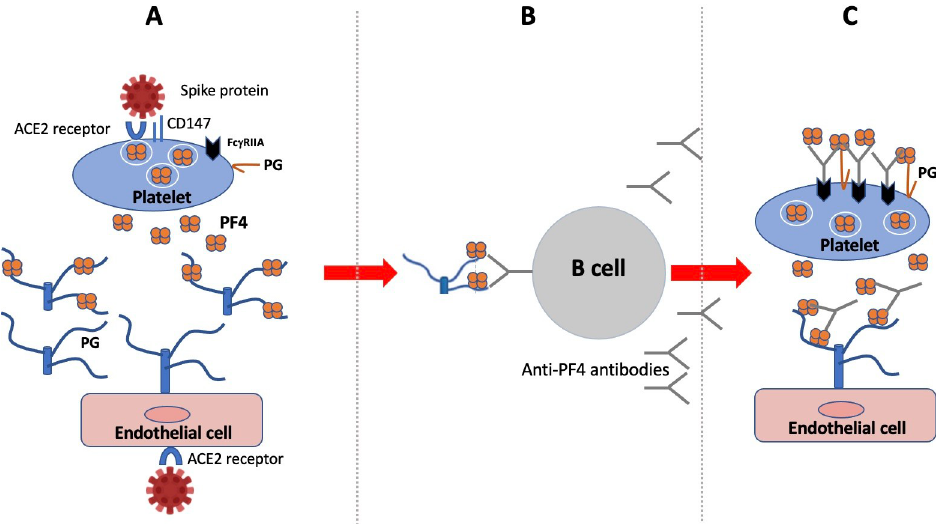
Fig 1. Hypothetical AU : PleasenotethatthecontentofFig 1 fileandFig 1 captiondonotmatch : PleasecheckandprovidenewFig 1 file : model for thrombotic thrombocytopenia during COVID-19. (A) SARS-CoV-2 induces the release of PF4 by activated platelets and of polyanionic PG by endothelial cells (e.g., syndecan and endocan). (B) Complexes of PF4 and PG expose PF4 immunogenic epitopes, which activate extrafollicular B lymphocytes secreting PF4 autoantibodies. (C) PF4 autoantibodies bind complexes of PF4 and PG on platelets and endothelial cells and stimulate their procoagulant activities. Cross-linking of Fc γ RIIA receptors also promote apoptosis and clearance of antibody-decorated platelets. COVID AU : AbbreviationlistshavebeencompiledforthoseusedinFigs 1 and 2 : Pleaseverifythatallentriesarecorrect : -19, Coronavirus Disease 2019; PF4, platelet factor 4; PG, proteoglycan; SARS-CoV-2, Severe Acute Respiratory Syndrome Coronavirus